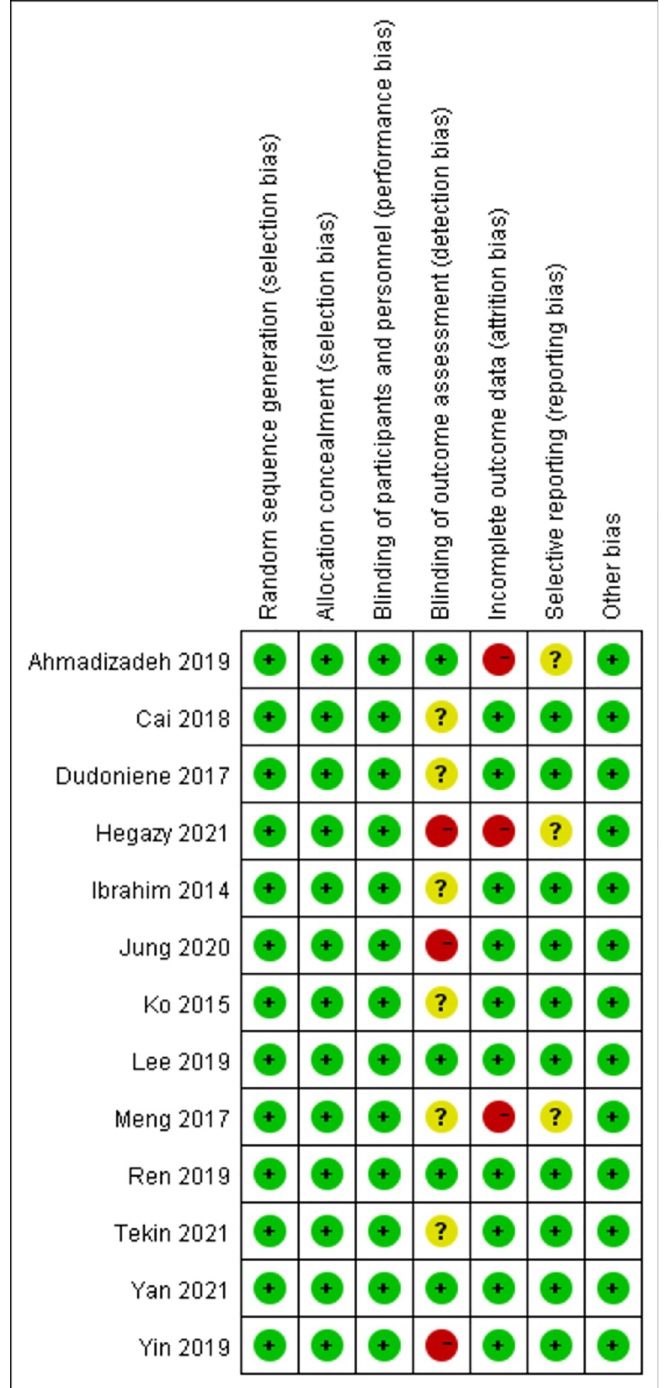
Fig 3. Risk of bias summary. The author’s judgments on each risk of bias item for each included study.